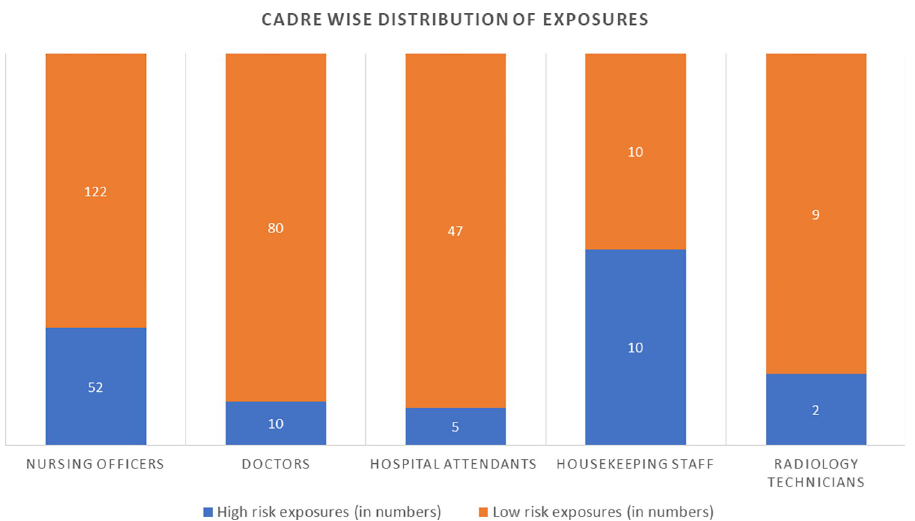
Fig 3. Breakdown of each cadre and the type of breach. (NSI: Needle stick injury).